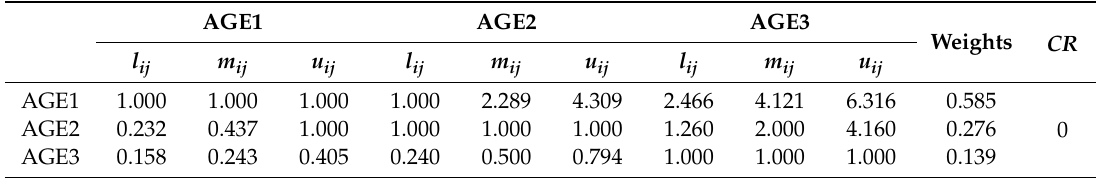
Table 4. Matrix of combined judgements using geometric means for the subcriteria of the criterion Age of the device. CR : consistency ratio.